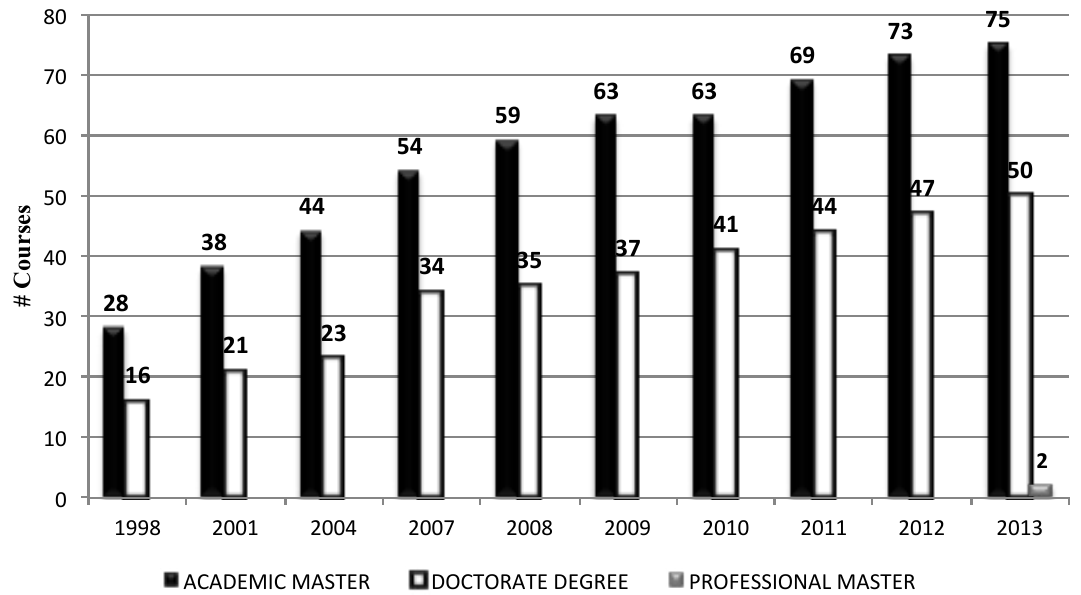
Figure 1. Growth in the number of academic master’s, professional master’s and doctorate Brazilian psychology postgraduate courses: 1998 to 2013.